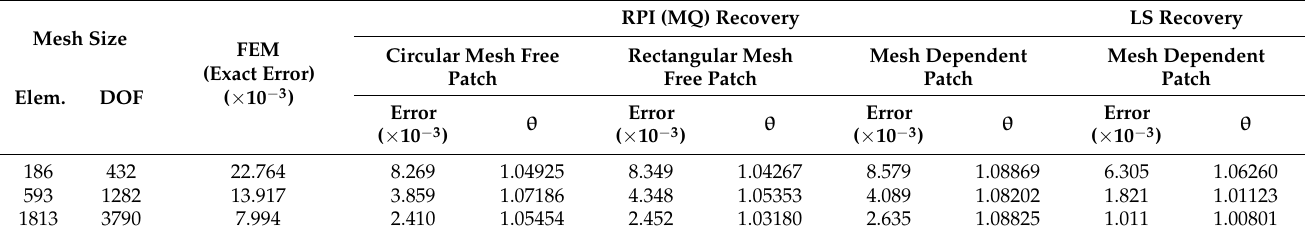
Table 10. Error convergence and global effectivity ( θ ) obtained for RPI (MQ) and least square based displacement recovery techniques (quadrilateral energy